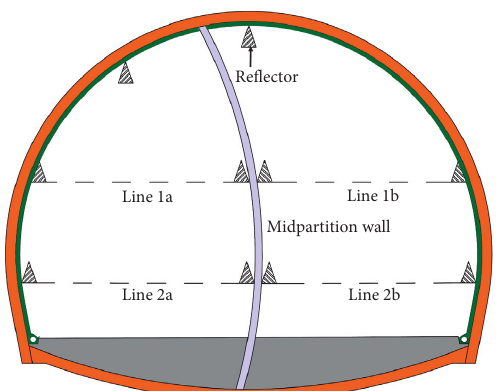
Figure 14: Layout of deformation measurement for the CD method.